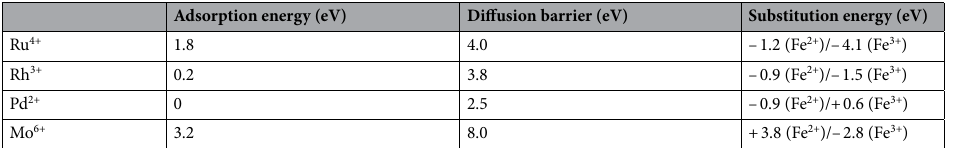
Table 3. The adsorption energy, diffusion barrier, and substitution energy of PGMs/Mo ions when incorporated into PB unit